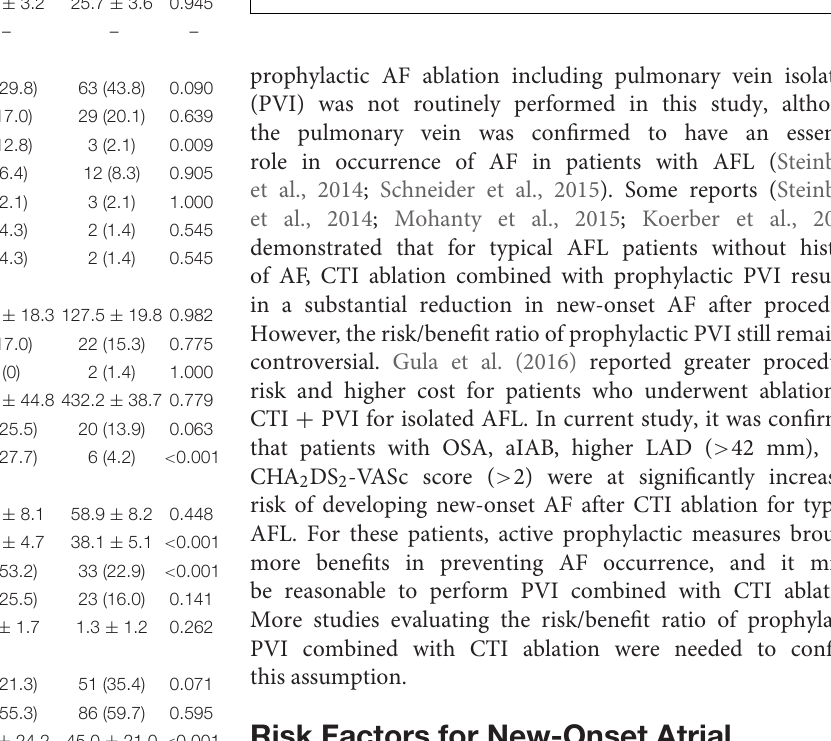
FIGURE 3 | Receiver operating characteristic curves for prediction of atrial fibrillation with left atrial diameter (LAD) (blue) and CHA 2 DS 2 -VASc score (green). The cut-off value of LAD was 42 mm with area under the curve (AUC) of 0.781 (sensitivity of 95.7% and specificity of 45.8%). The cut-off value of CHA 2 DS 2 -VASc score was 2 with AUC of 0.550 (sensitivity of 29.8% and specificity of